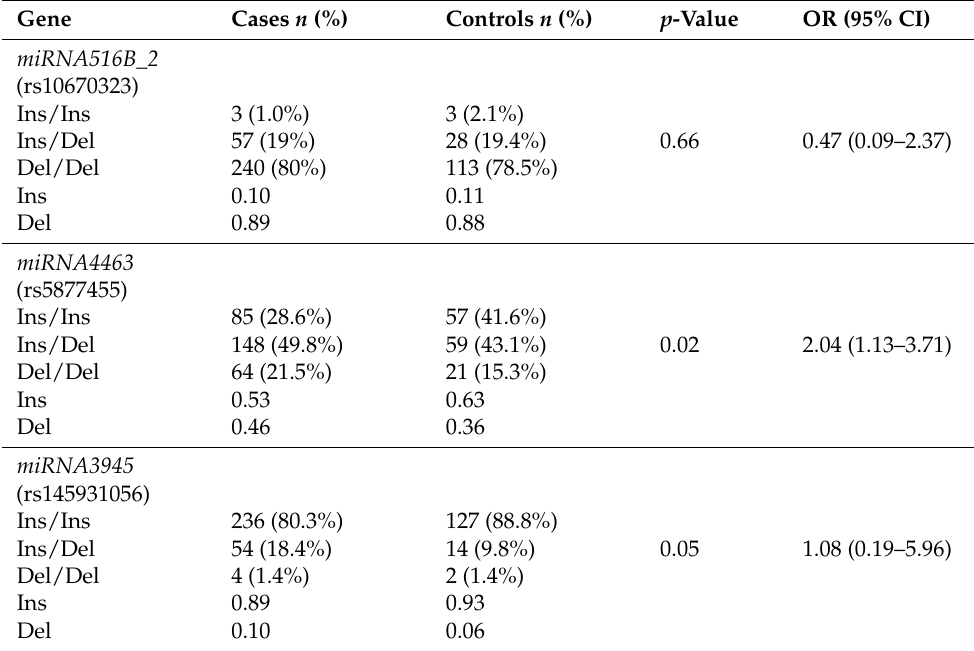
Table 3. Genotypic and allelic frequency of selected INDELs from NCBI